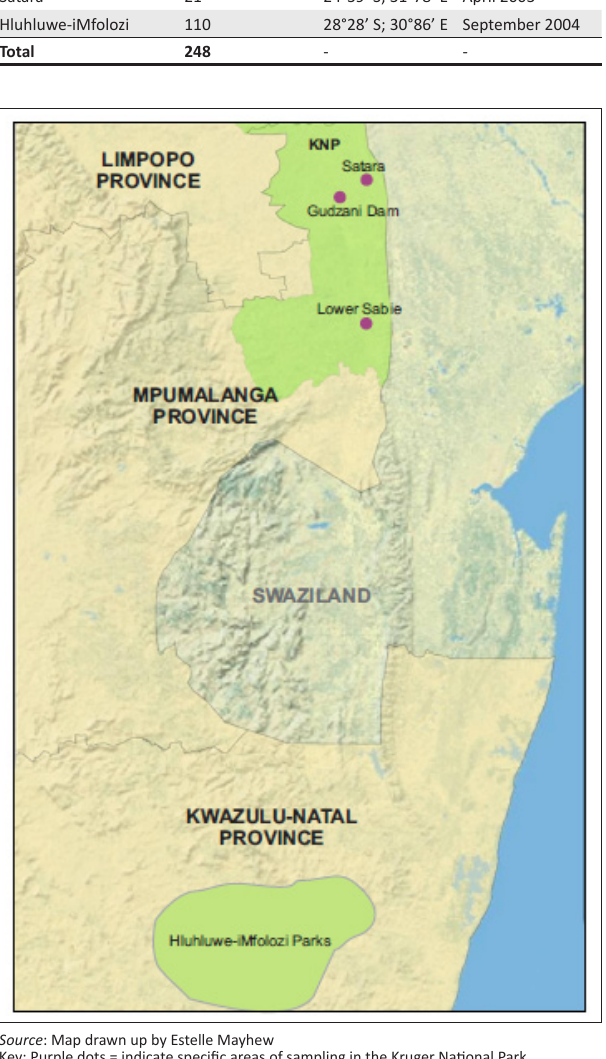
FIGURE 1: Sites where samples were collected in the Kruger National Park and Hluhluwe-iMfolozi Park, South Africa.